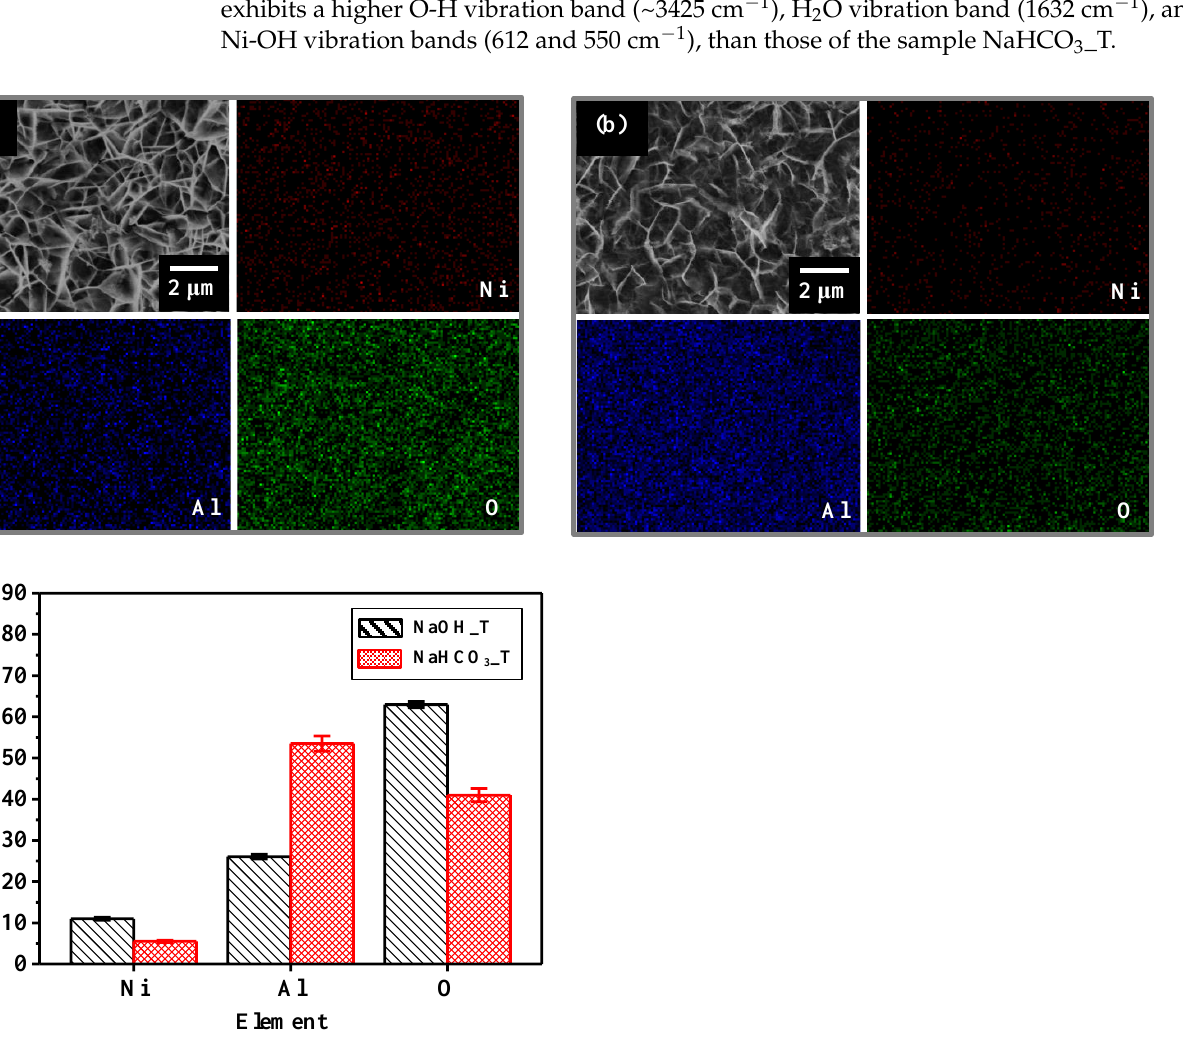
Figure 7. SEM surface morphologies of the sample NaOH_T and NaHCO 3 _T with compositional maps for Ni, Al, and O are shown in ( a , b ), respectively; ( c ) EDS analyses of the elemental compositions and contents of the samples NaOH_T and NaHCO 3 _T.